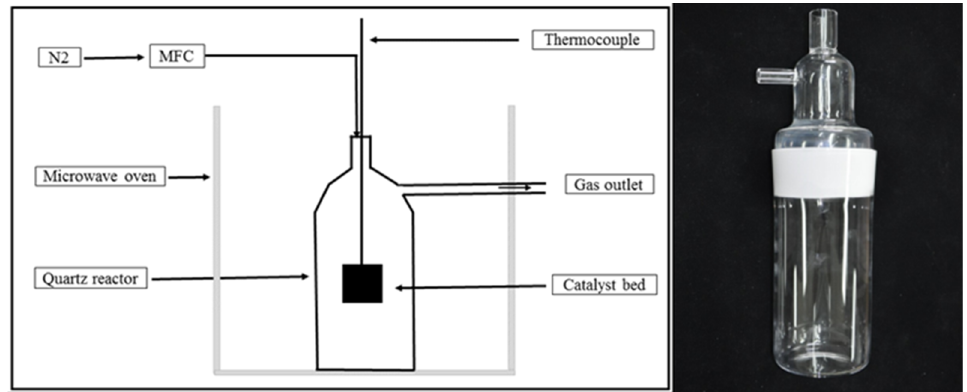
Figure 1. Schematic diagram of the catalytic graphitization setup (left); self-designed quartz reac- tor (right).